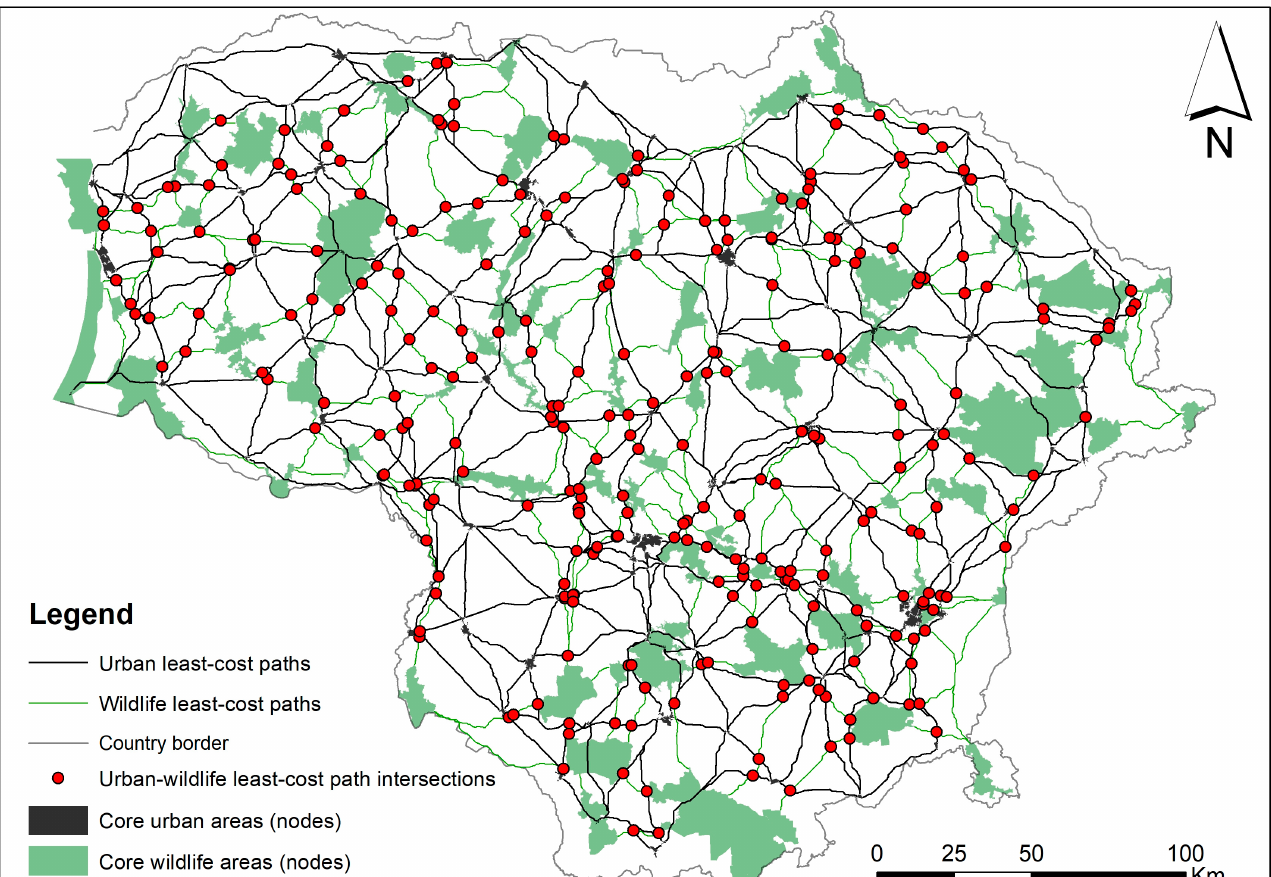
Figure 5. Intersections of urban and wildlife least-cost paths